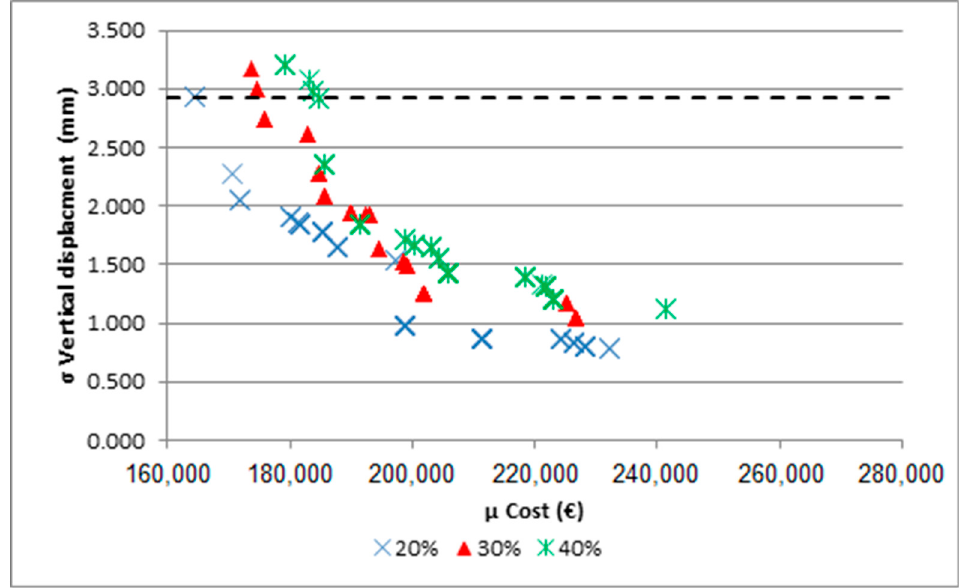
Figure 5. Pareto frontier of overload RDO problems. Mathematics 2020 , 8 , x FOR PEER REVIEW Table 8. Comparison of designs with the same structural behavior in overload RDO problems.